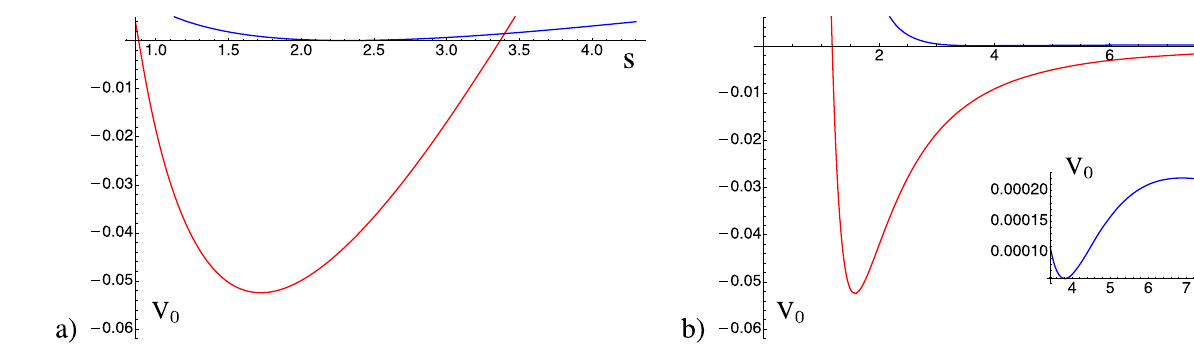
Fig. 3 Plots for the uplift mechanism by employing the A (cid:2) contri- is observed that the uplift reduces the mass of the scalar field while D 5 bution. In red we show the effective potential in an AdS minimum its expectation value moves to the right as s = 2 . 4473, τ = 3 . 8434. = 0 . 77046, A = 0 . 24018, A = defined by the contributions A F Notice that the uplift of the Kähler moduli produces a nearly flat direc- H 3 O 3 3 − 1 . 6974, A = 0 . 97955 and with moduli vev’s given by s = 1 . 7911, tion, which is compatible with the KKLT F 5 τ = 1 . 5603. By adding non-BPS (cid:2) D 5-branes with A (cid:2) = 0 . 43564, it D 5